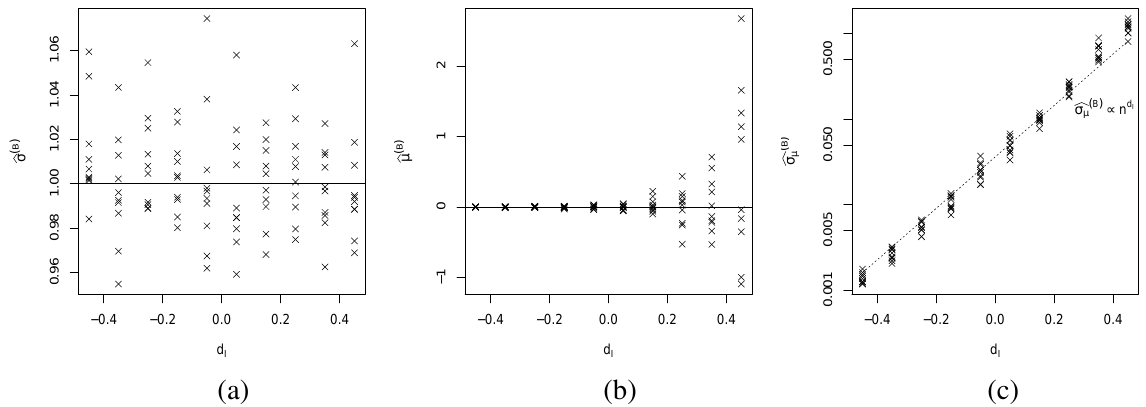
Figure 2. Posterior outputs: (a) Bayesian estimated standard deviation b σ ( B ) against true d I values; (b) Bayesian estimated mean b µ ( B ) against d I ; and (c) uncertainty in the posterior for µ , the standard deviation c σ µ( B ) against d I (semi-log scale). Each “x” plotted corresponds to an estimate.